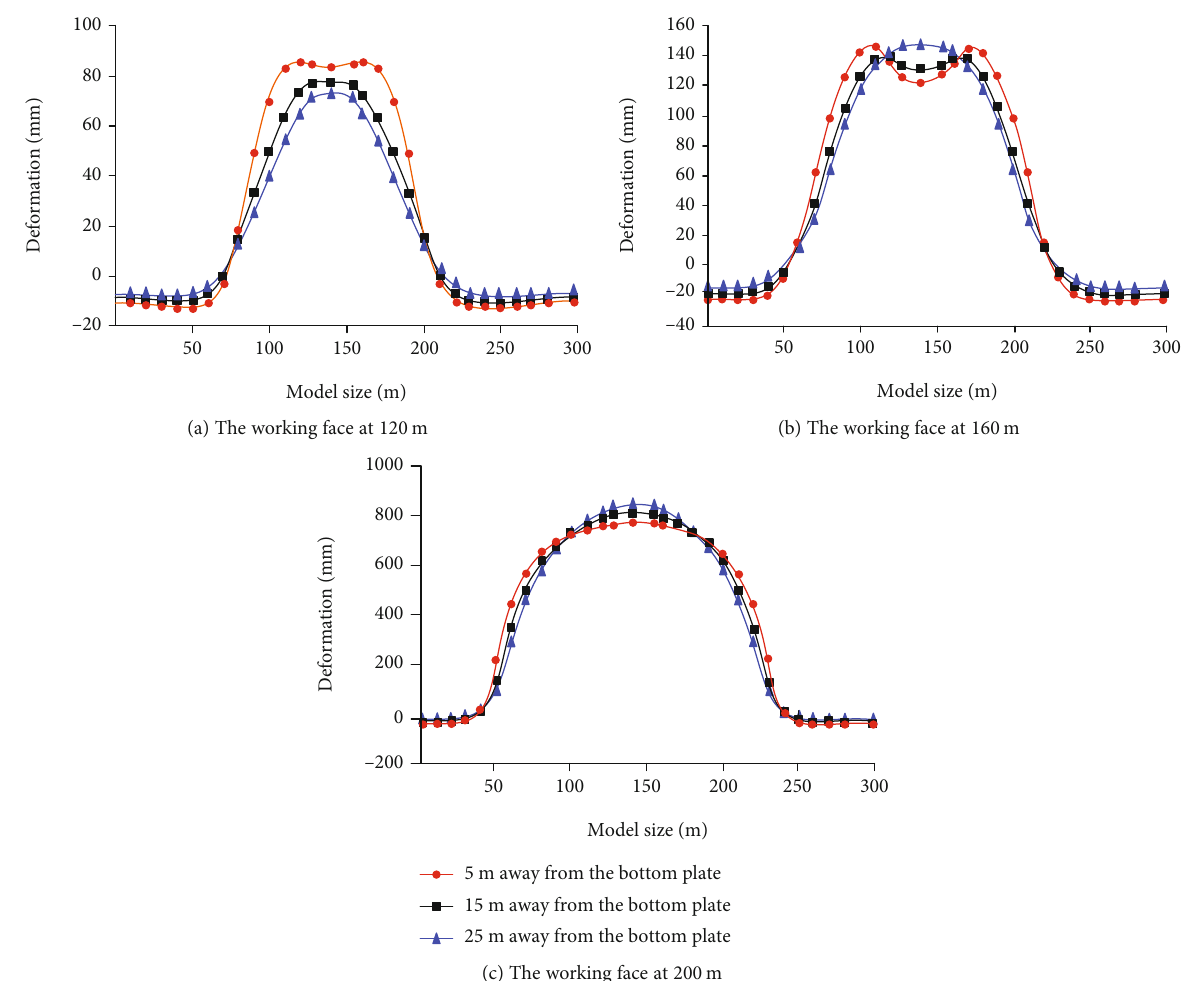
Figure 11: Floor movement and deformation